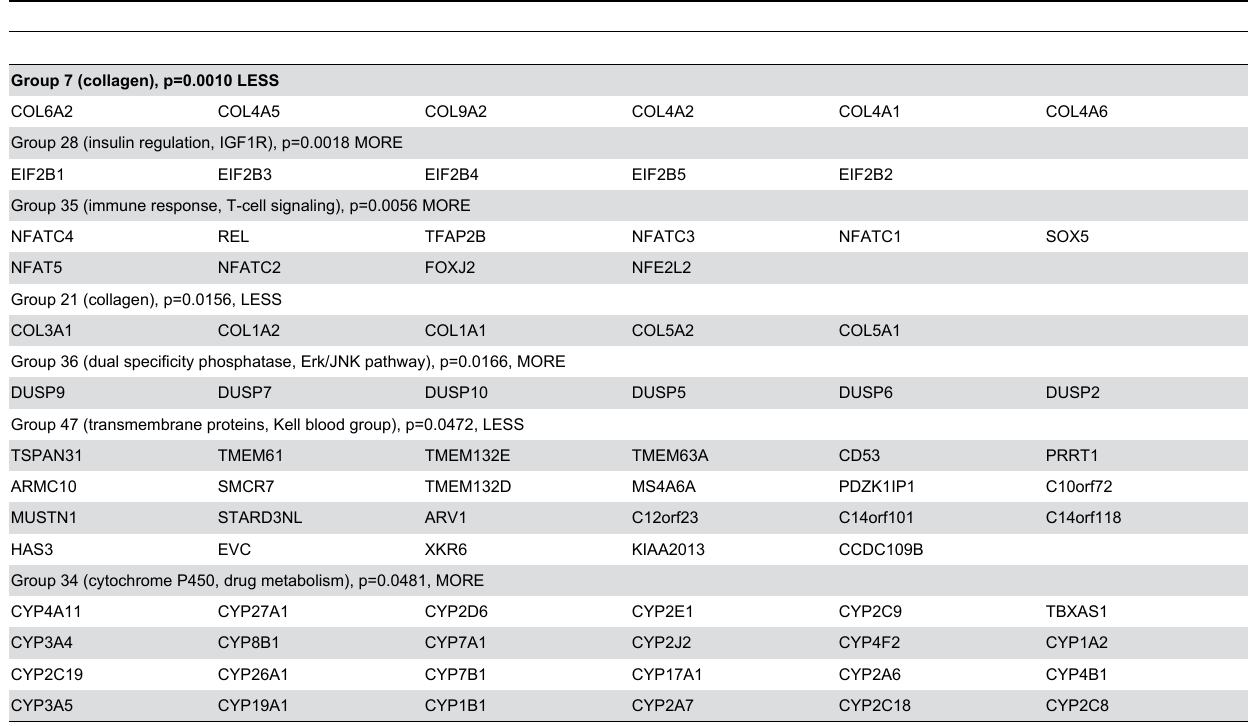
Table 3. Characteristics of 7 Gene Groups showing significantly more or less SNPs with differing prevalences.